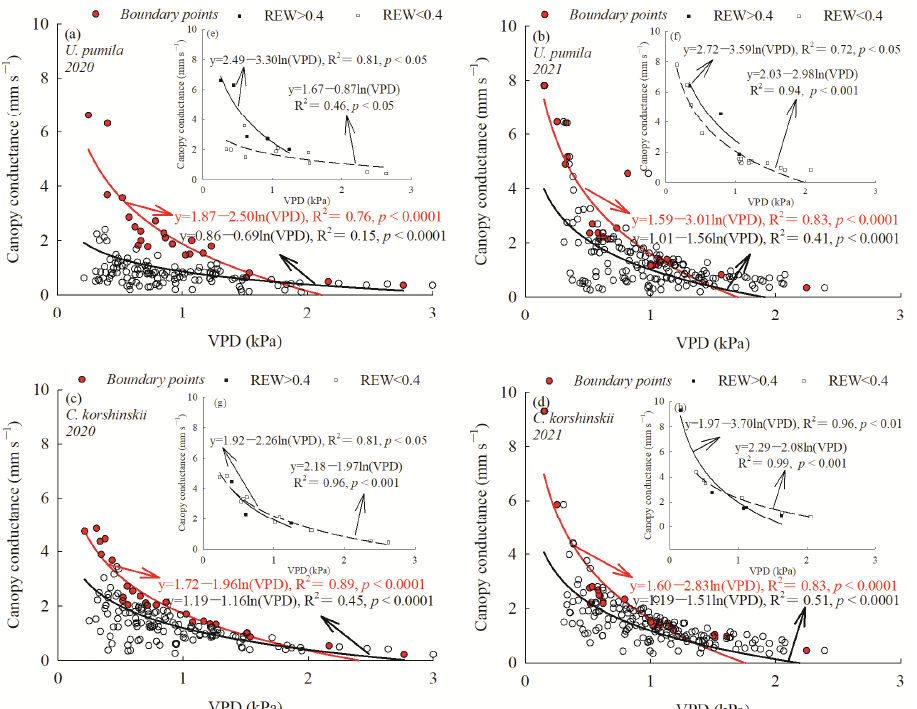
Figure 8. Relationships between canopy conductance per ground area and daily vapor pressure deficit in the measurement periods (black line) and boundary line analysis (red line) for U. pumila and C. korshinskii in 2020 ( a , c ) and 2021 ( b , d ); boundary line analysis under stressed (REW < 0.4) and non-stressed (REW > 0.4) conditions for U. pumila and C. korshinskii in 2020 ( e , g ) and 2021 ( f , h ).